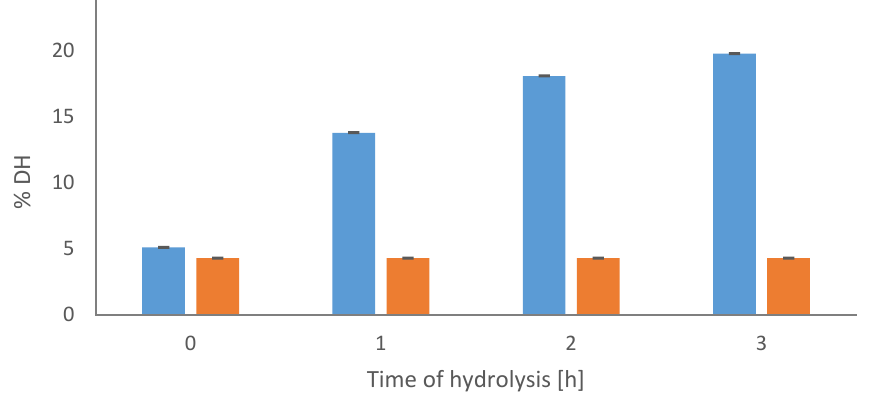
Figure 1. Hydrolysis degree (%DH) of casein degraded with the extracellular serine protease preparation from Yarrowia lipolytica yeast, at the dose of 500 U/g [blue], and in control sample: non- hydrolyzed isolelectric casein [orange].